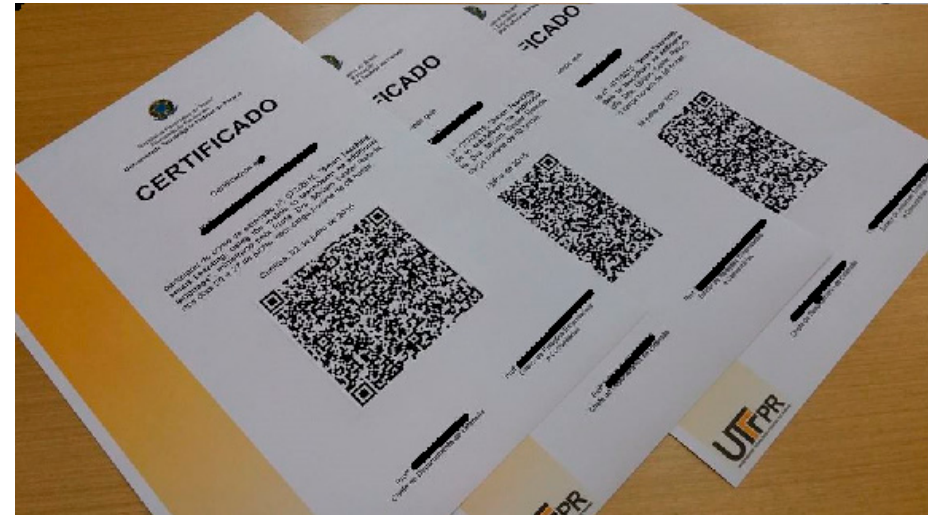
Figure 7. Official certificate of the workshop Smart Teaching, Smart Learning: Using the mobile to teach/learn an additional language.